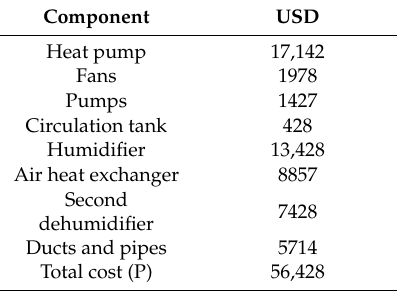
Table 3. Cost of the